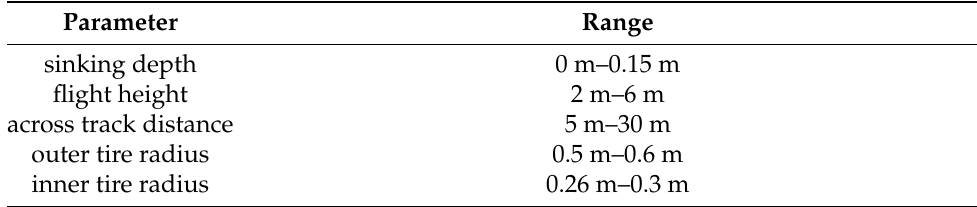
Table 2. Parameters varied in the ray-tracing